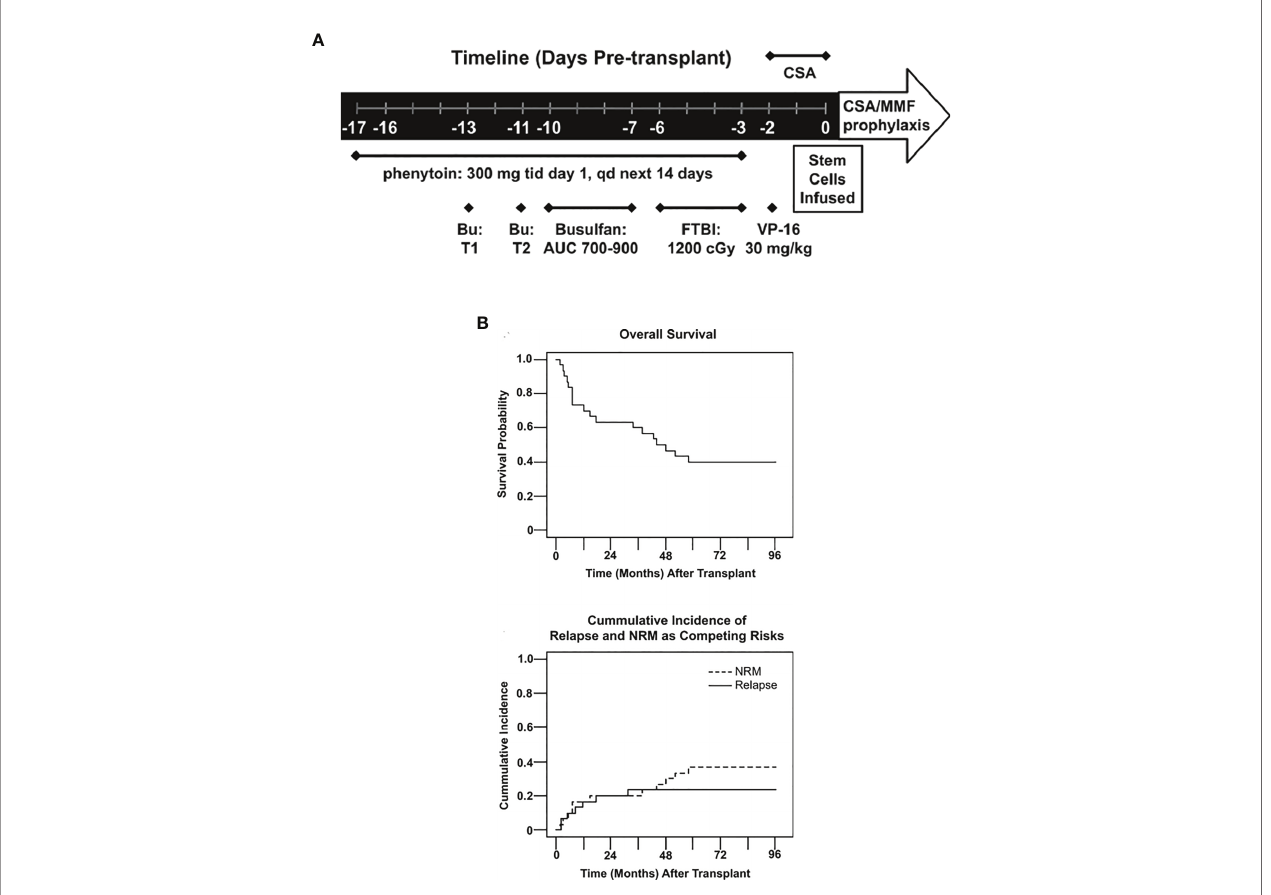
FIGURE 4 | (A) Treatment schema. Treatments including dosages are listed under the timeline. BU, bulsulfan, T1, test dose 1, T2, test 2, FTP I, fractionated total body irradiation, CSA, cyclosporine, MMF, mycophenolate mofetil, qd, once daily, tid, three time daily. (B) Overall survival probability and Cumulative incidence of relapse and NRM as competing